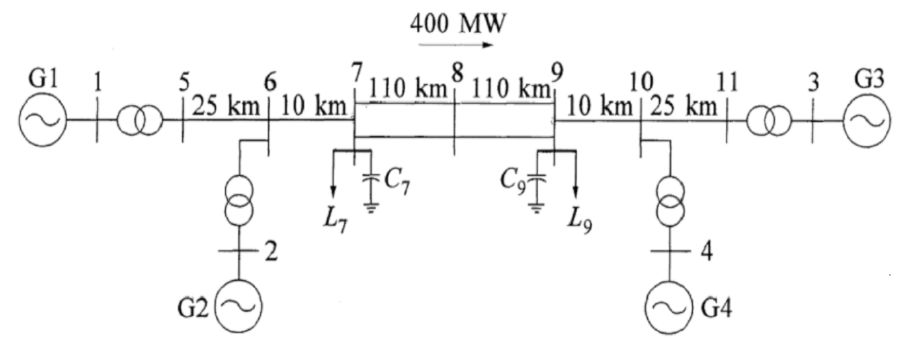
Figure 16. Single line diagram of Kundur’s four machine two-area model adopted to obtain test inter-area